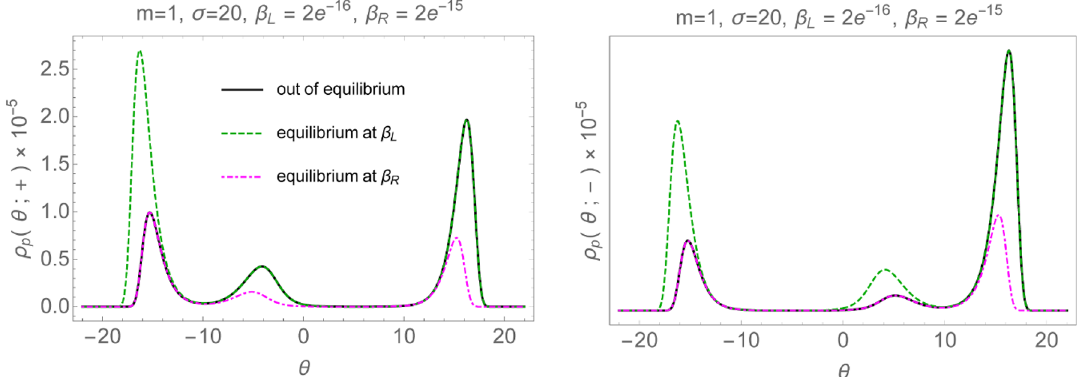
Figure 11 . Spectral densities at equilibrium for temperatures (cid:12) = (cid:12) R = 2 e (cid:0) 15 and (cid:12) = (cid:12) L = 2 e (cid:0) 16 and out of equilibrium for the same